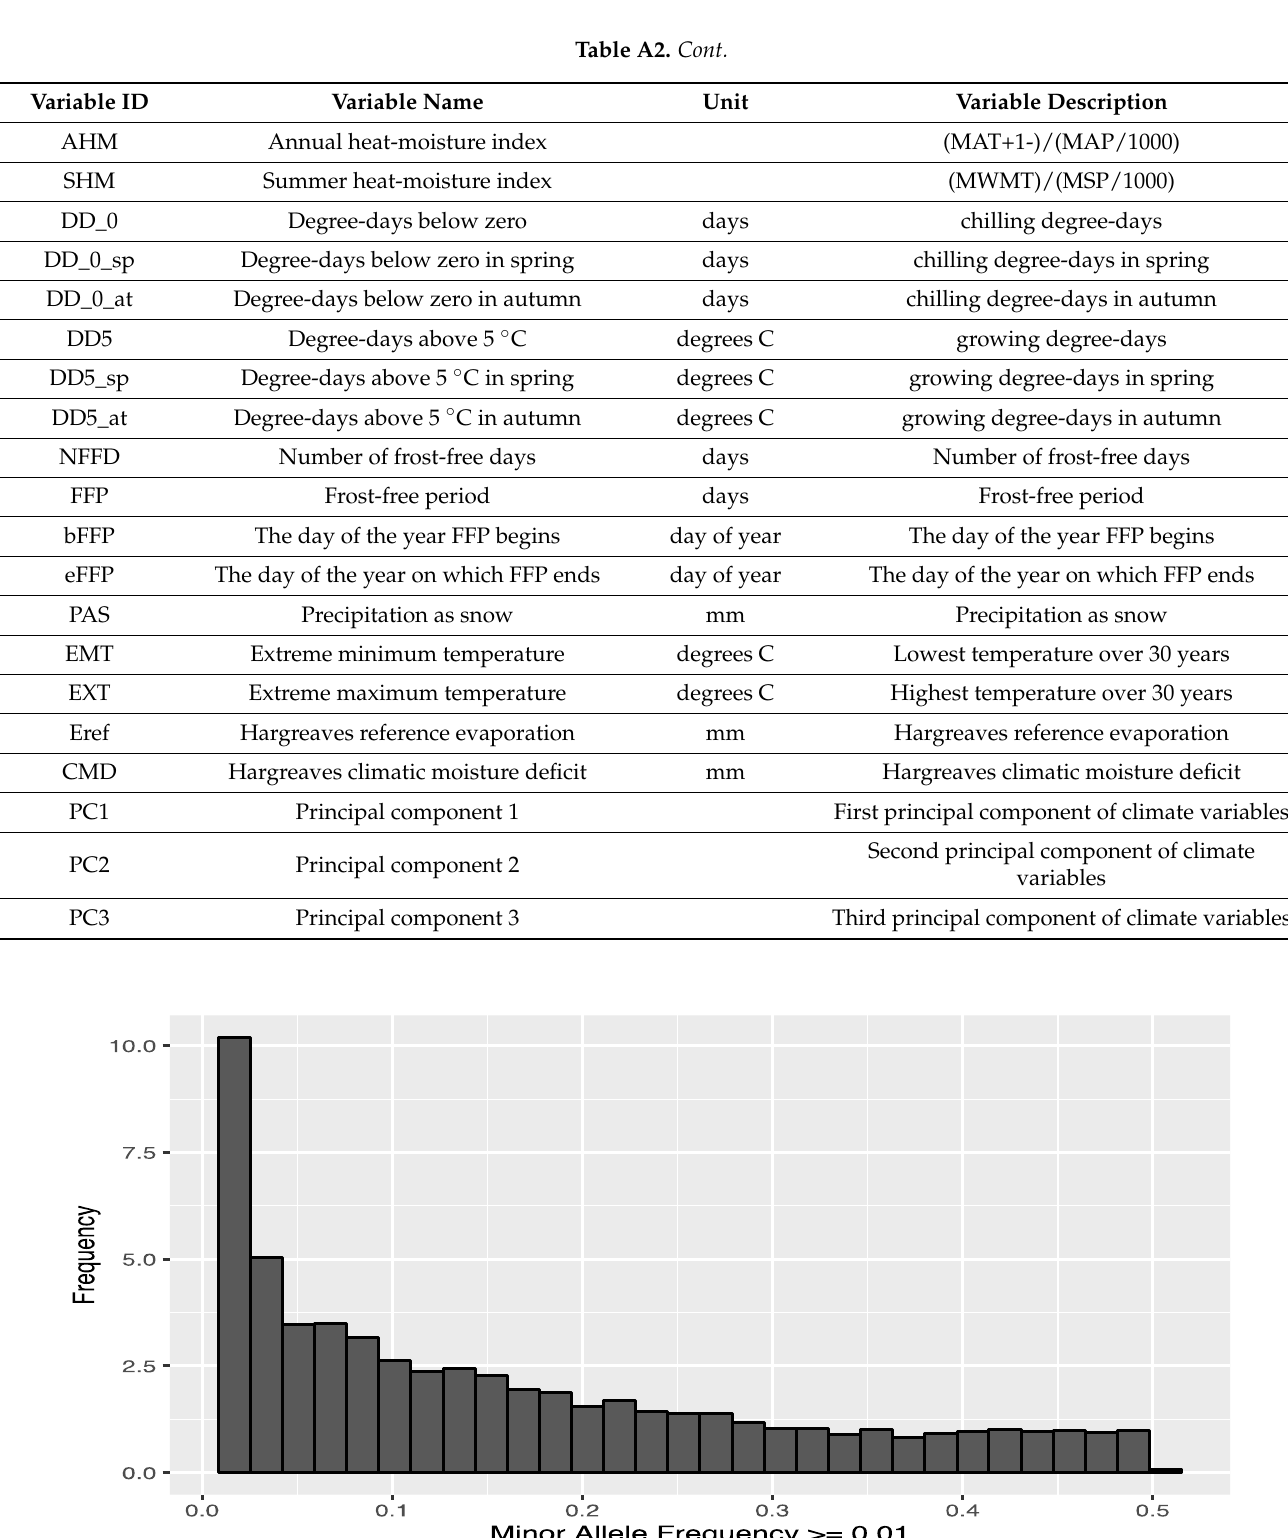
Figure A1. Histogram showing the distribution of minor allele frequency for the 20,397 SNPs included in this study.